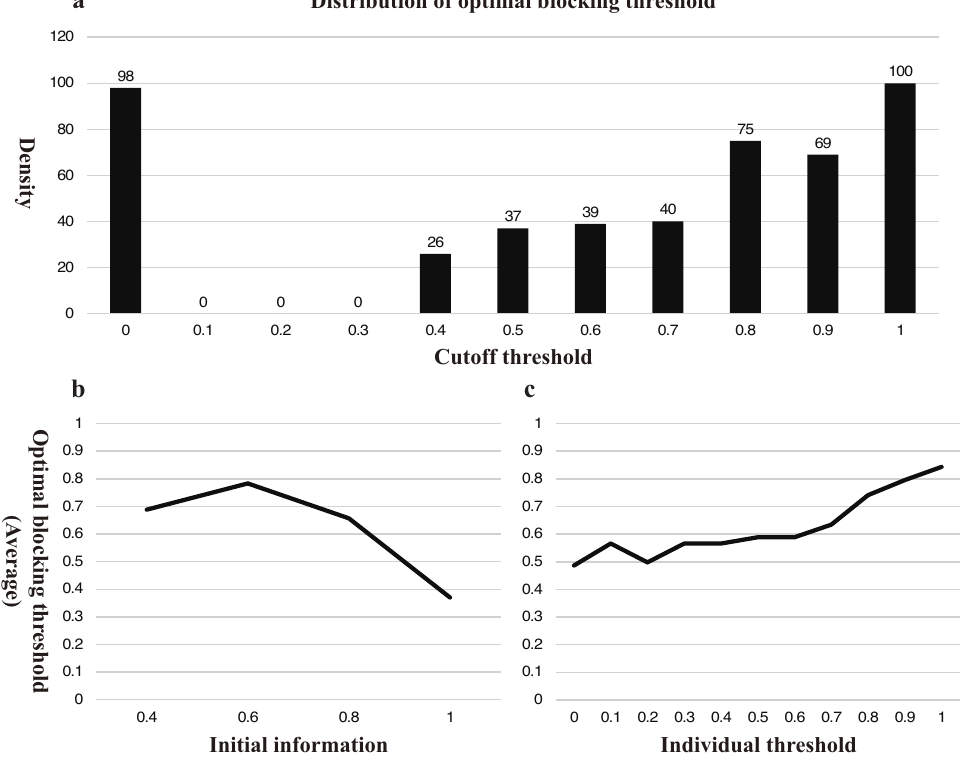
Figure 5. Simulation results for government’s trade-off in blocking. ( a ) conveys the distributions of optimal blocking threshold under 484 different external scenarios (4 pieces of initial information, 11 individual thresholds, and 11 disclosing thresholds). We show how the figure works by taking the first column as an example: there are 98 conditions in which 0 is the lowest infection rate; ( b ) conveys the relationship between initial information and blocking threshold; and ( c ) conveys the relationship between individual threshold and blocking